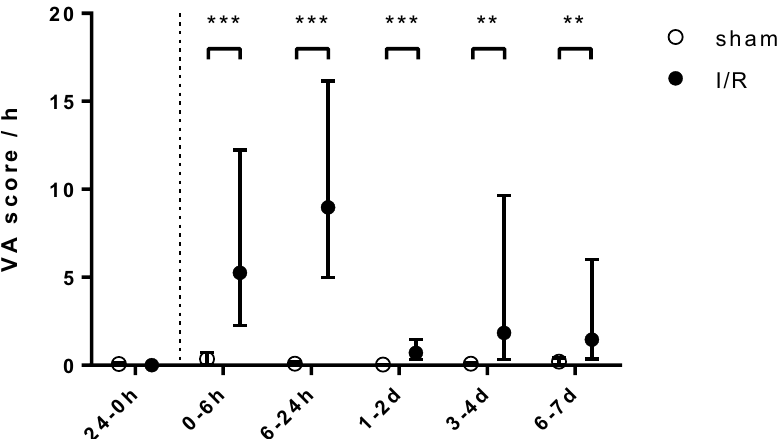
Figure 2. The susceptibility for spontaneous VA increases in the subacute stage after I/R. The herein applied arrhythmia score rates both number and severity of VA (see “Methods” section). VA score values of one hour are averaged at each given time interval. Data are given as geometric mean and 95% confidence interval (BL, p = 0.393; 0–6 h; *** p < 0.001; 6–24 h; *** p < 0.001; 1–2 days; *** p < 0.001; 3–4 days; ** p = 0.003; 6–7 days; ** p = 0.004; sham n = 6, I/R n = 10, non-parametric Mann Whitney